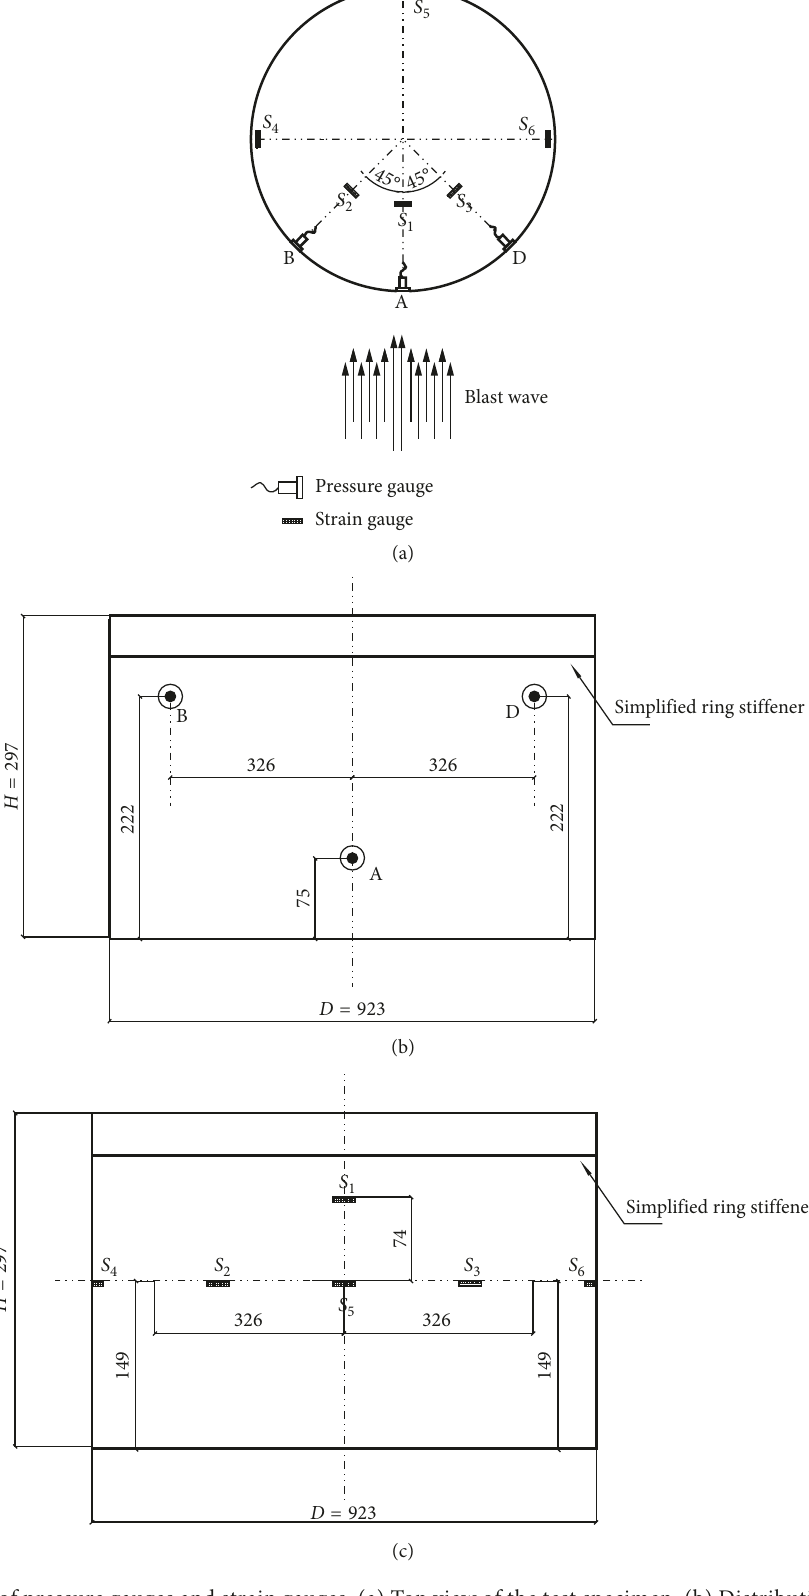
Figure 3: Distribution of pressure gauges and strain gauges. (a) Top view of the test specimen. (b) Distribution of pressure gauges. (c) Distribution of strain